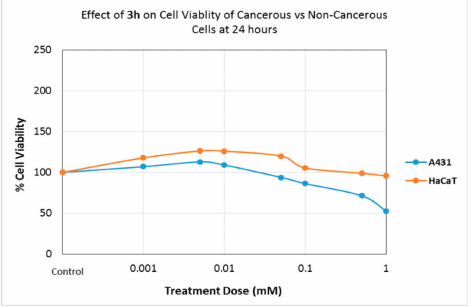
Figure 3. E ff ect of 3h on cell viability of cancerous vs. noncancerous cells at 24